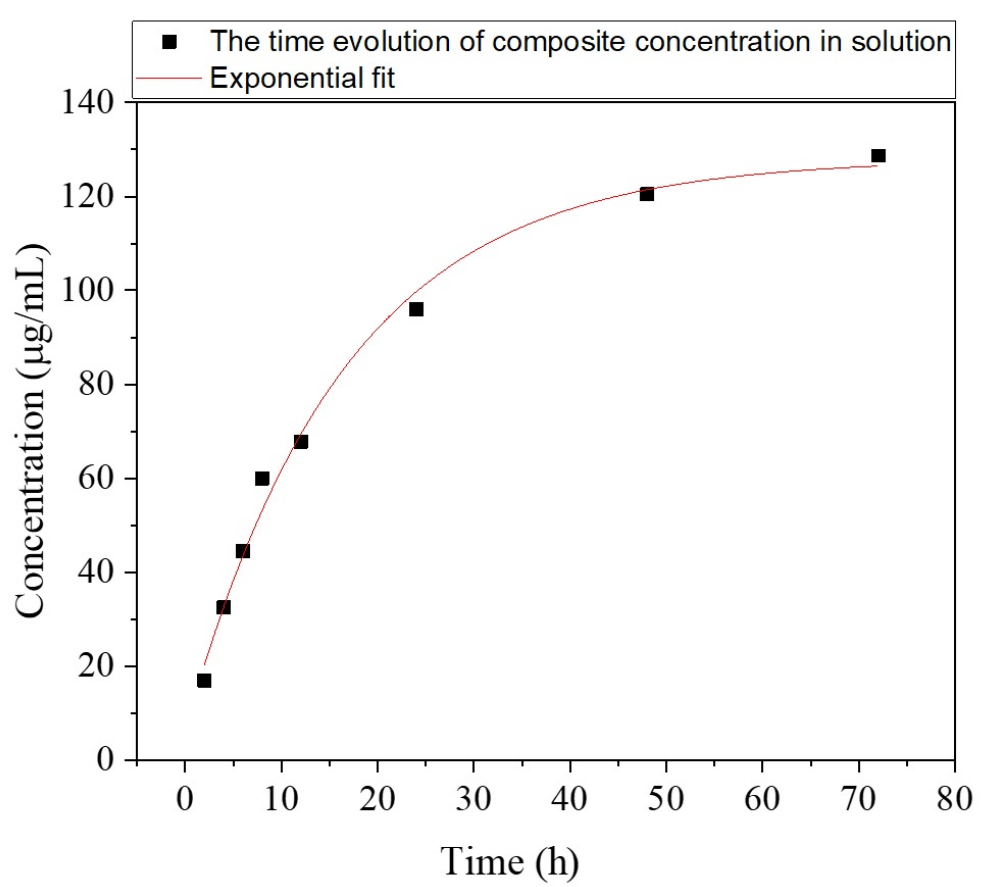
Figure 16. The time evolution of composite concentration in solution, c(t) .